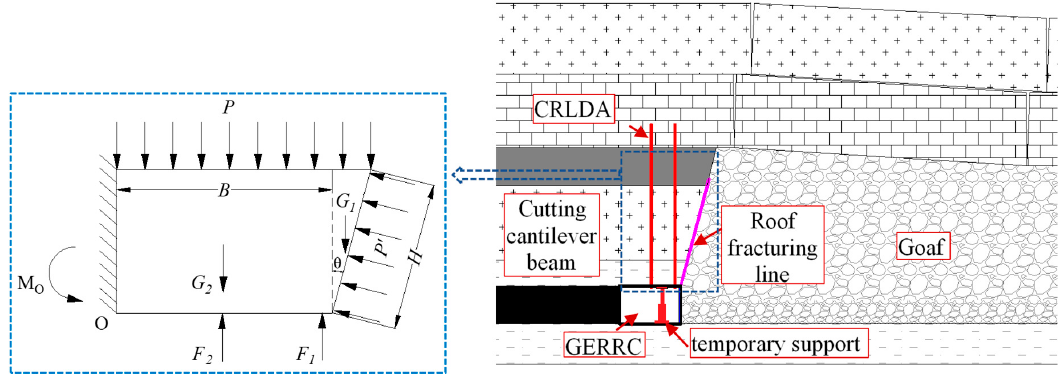
Figure 13. Mechanical model of the GERRC.